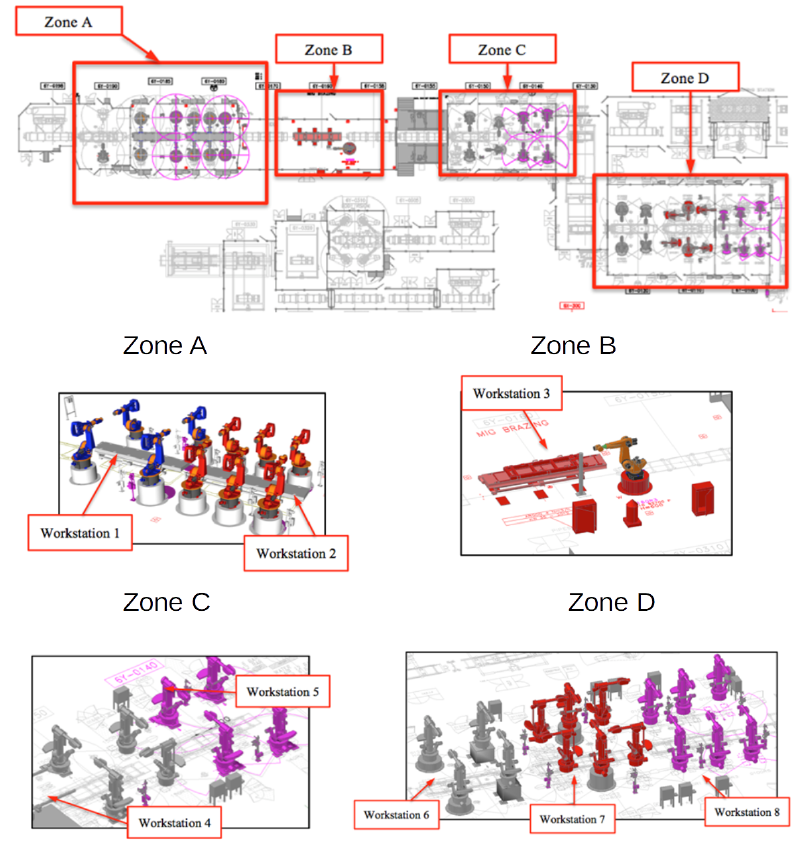
Figure 7. Layout welding